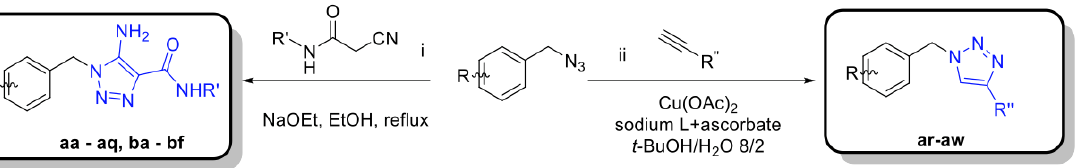
Figure 1. Main synthetic paths to generate carboxyamidotriazole derivatives. The key fragments benzyl azide, N -substituted-2-cyanoacetamides and alkynes were prepared by conventional synthetic methods. The 5-amino-4-carboxyamido-1,2,3-triazole derivatives were assembled by a 1,3-dipolar cycloaddition between 2-cyanoacetamide or N -substituted 2-cyanoacetamides with the corresponding benzyl azides, using sodium ethoxide as a base, as previously reported [31,32]. Another series of N -substituted 1,2,3-triazoles, lacking the amino group on the 5-position of the heterocycle, were also prepared by Huisgen-Click cycloaddition reaction between a suitable benzyl azide and an alkyne, using the standard copper acetate/sodium ascorbate system as a catalyst [33]. Table 1. List of aa compound derivatives and corresponding structures. Compound No.